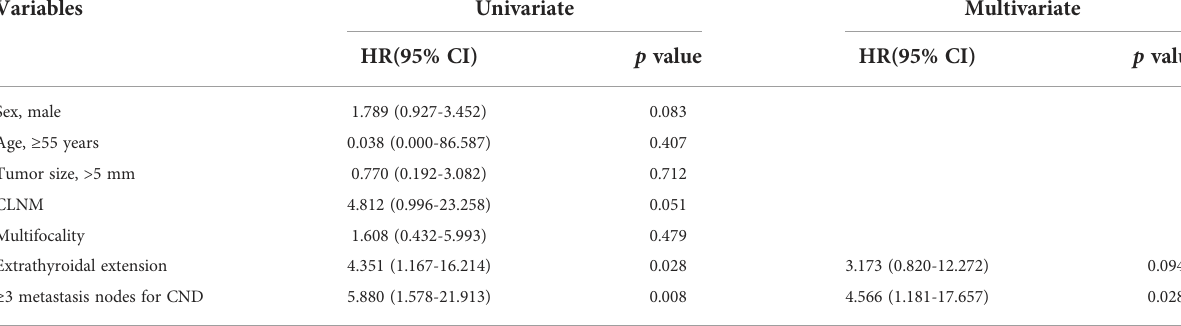
TABLE 5 Univariate and Multivariate Analysis of Variables Associated with tumor